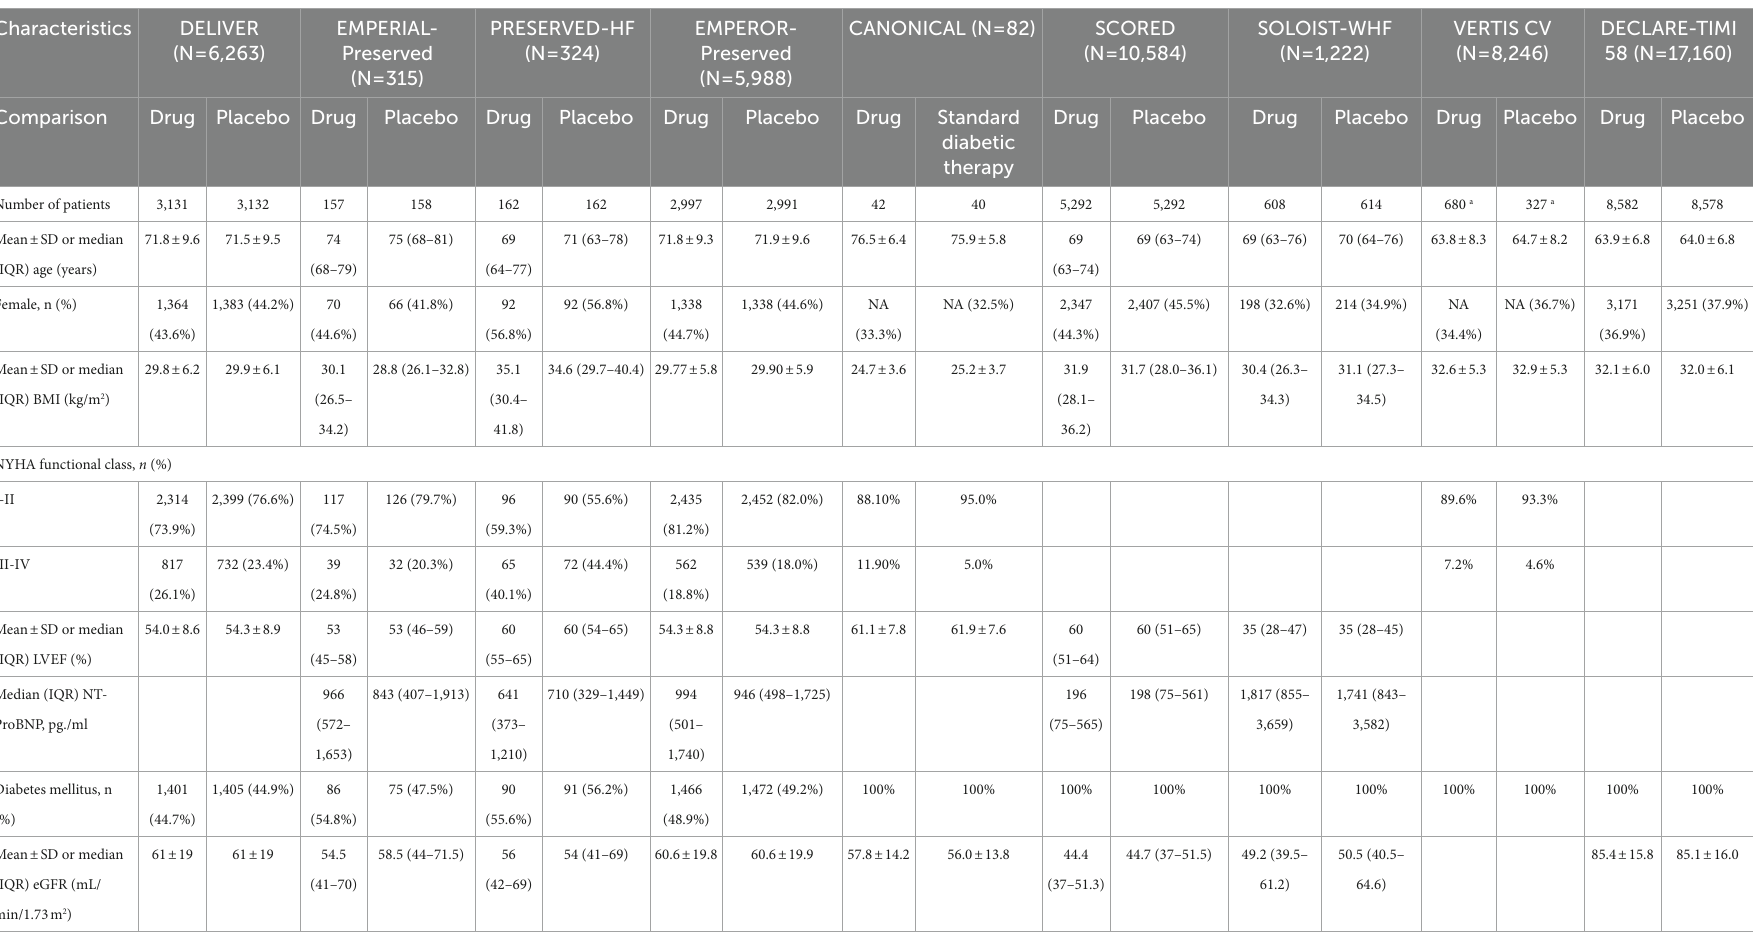
TABLE 2 Patient baseline characteristics from the 9 randomized controlled trials included in this study, and from which data were analyzed and reported by the other 7 post-hoc studies included in this study.